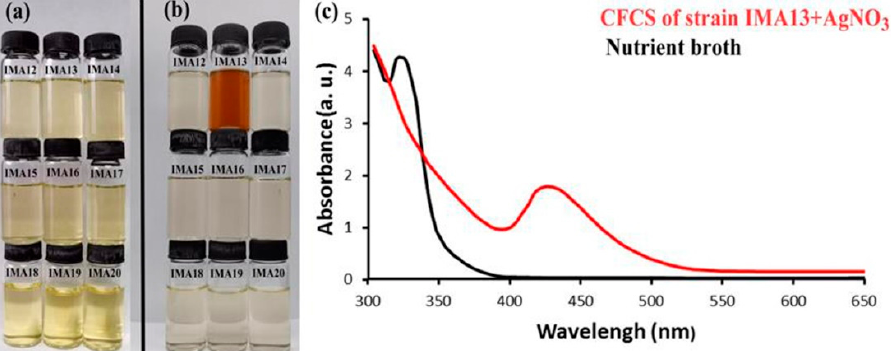
Figure 1. Synthesis of nanoparticles using cell-free culture supernatant (CFCS) of nine bacteria strains and UV-visible spectra of synthesized AgCl-NPs after incubation at 30 °C and 200 rpm for 48 h: ( a ) visual color change before incubation; ( b ) visual color change after incubation for 48 h; ( c ) the absorption spectrum of AgCl-NPs synthesized using IMA13 CFCS, showing a strong peak at 430 nm after 48 h.